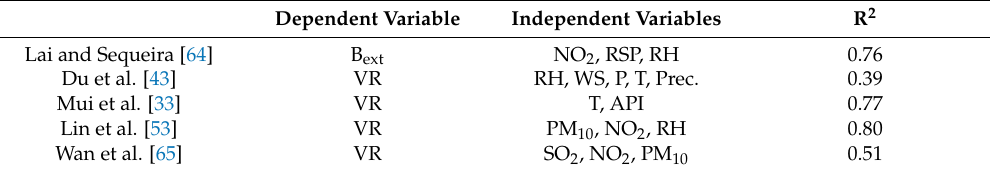
Table 5. Results of the previous studies on the same topic for Hong Kong and mainland China. Dependent Variable Independent Variables R